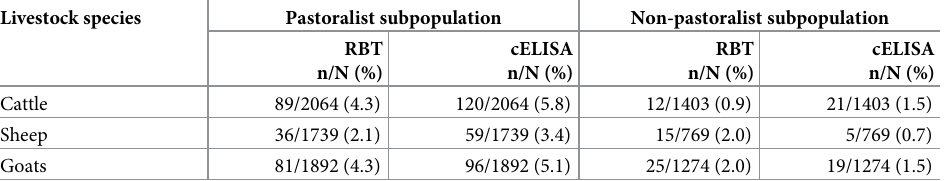
Livestock species